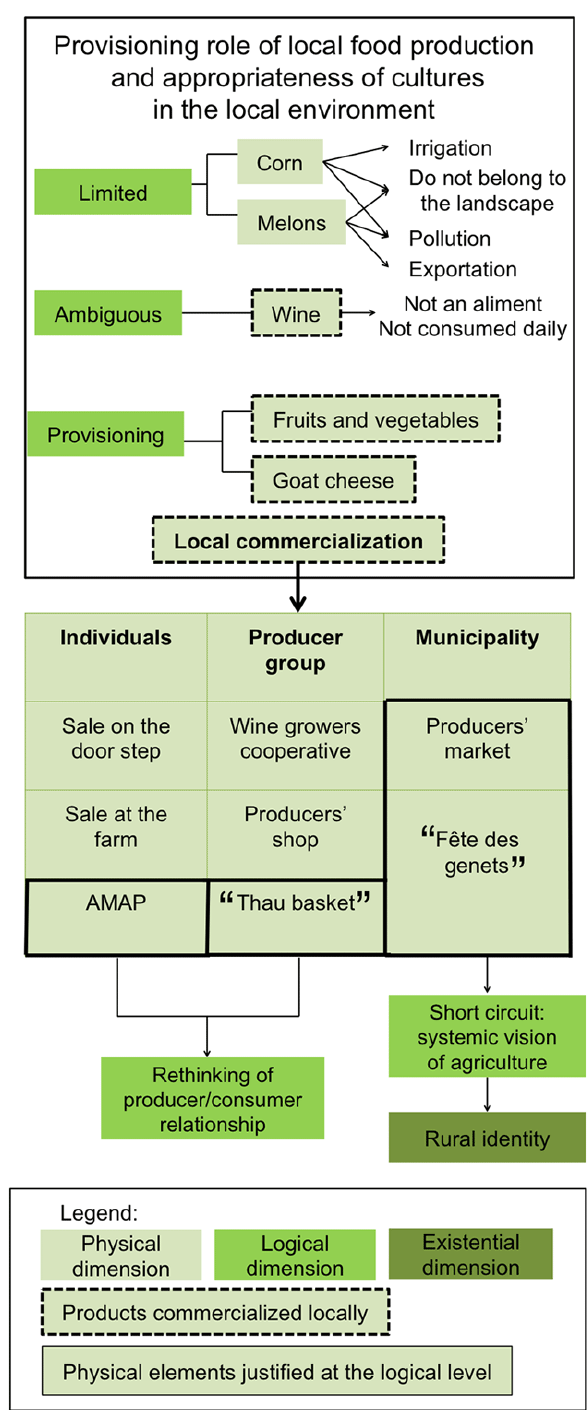
Association pour le Maintien d’une Agricultural